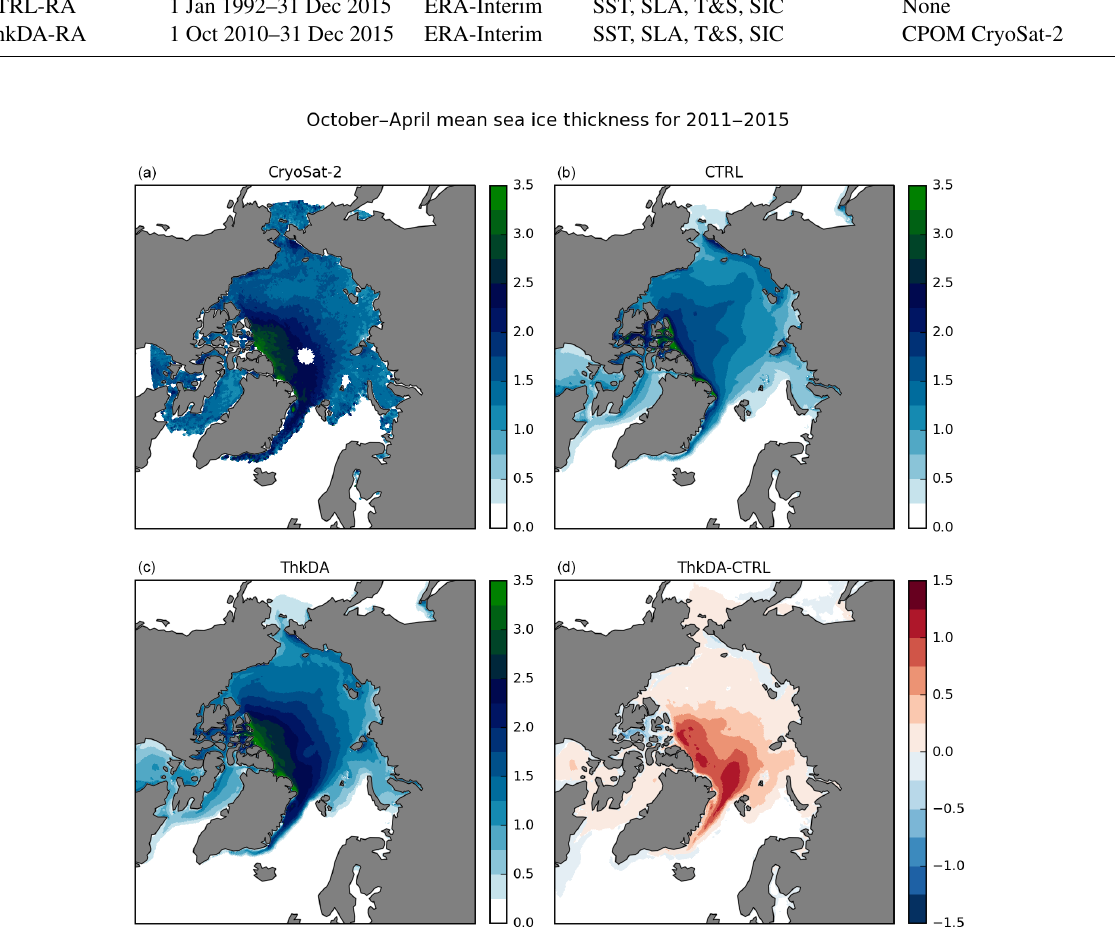
Figure 1. Mean winter (October to April) Arctic sea ice thickness (m) from October 2010 to April 2015 for (a) CPOM CryoSat-2 mea- surements, after application of the QC and imposing the 1m minimum thickness threshold; modelled thickness from (b) the CTRL and (c) ThkDA reanalyses. Panel (d) shows the difference between the ThkDA and CTRL